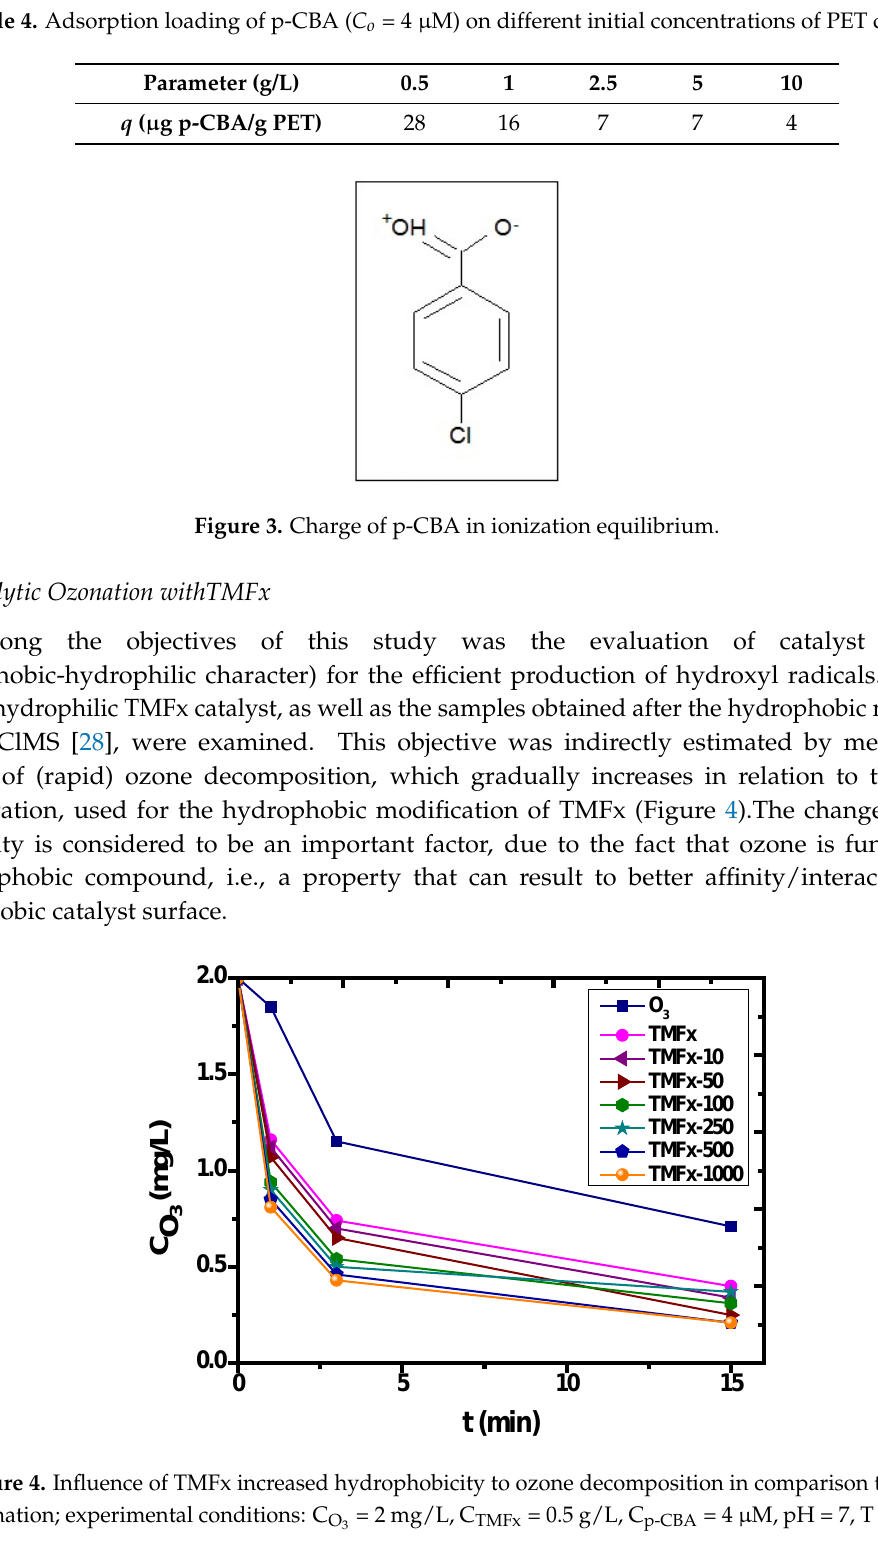
Figure 4. Influence of TMFx increased hydrophobicity to ozone decomposition in comparison to single ozonation; experimental conditions: C O = 2 mg/L, C TMFx = 0.5 g/L, C p-CBA = 4 µ M, pH = 7, T = 20 °C.